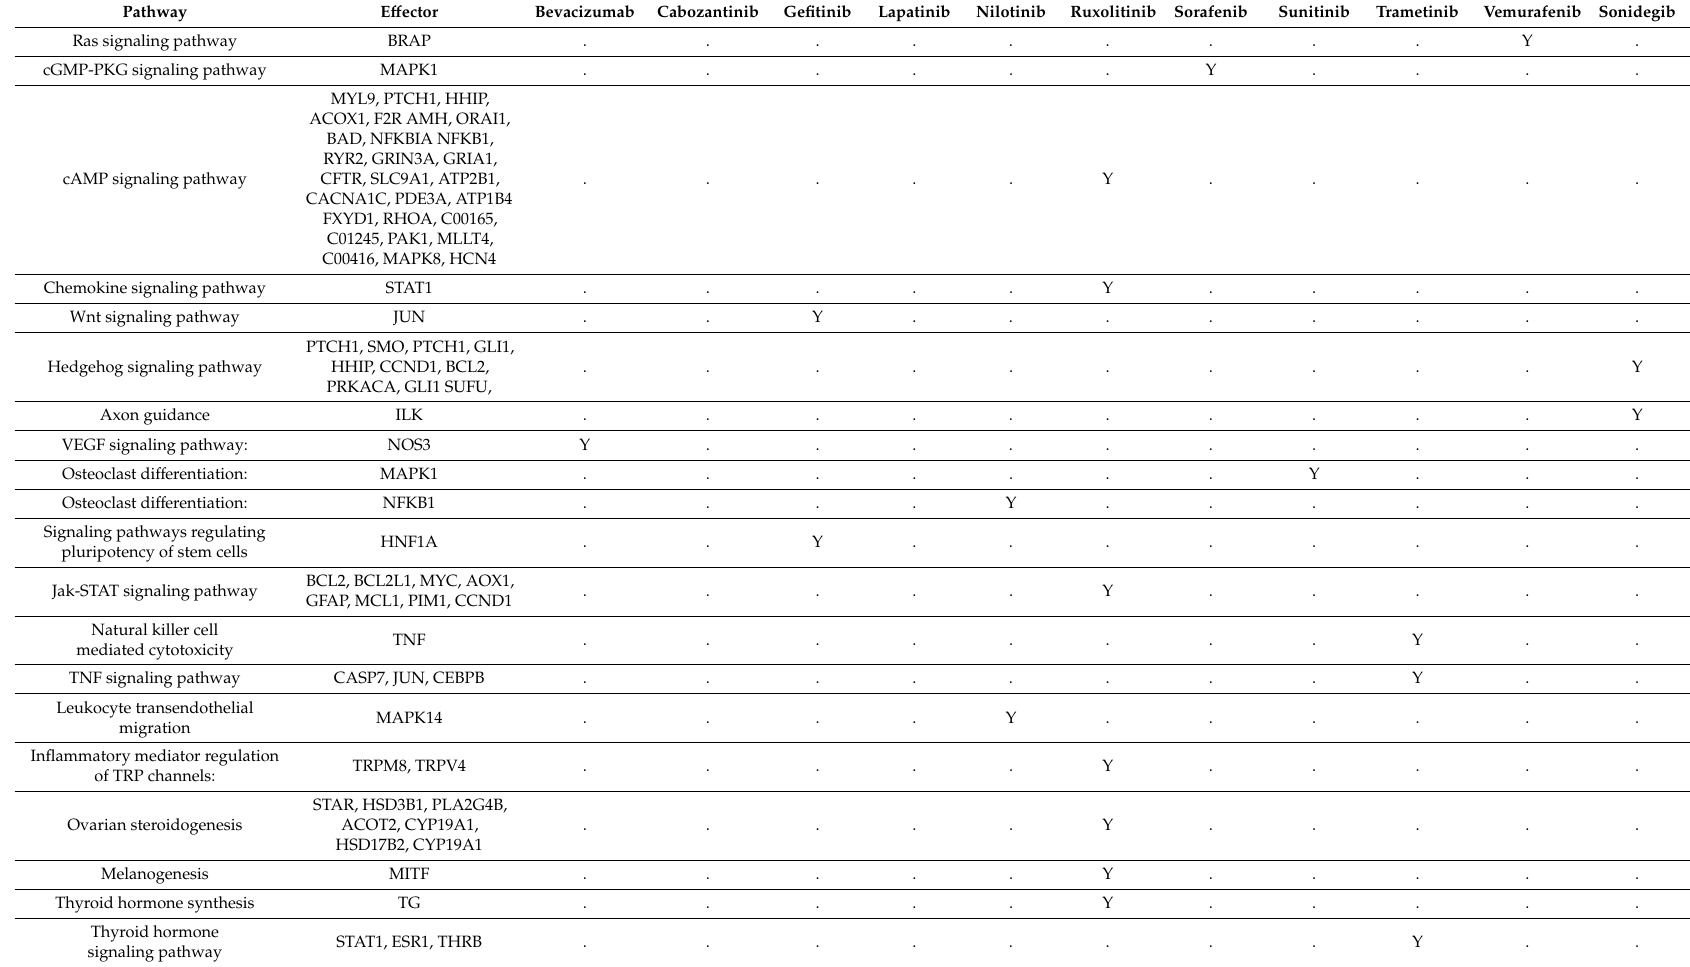
Table 4. Simulation of the e ff ect that drugs, with described gender bias, have over signaling circuits (described as pathway and the final e ff ector of the circuit). Circuits for which a GS-DSA is detected after the simulation of the drug are marked with “Y”.